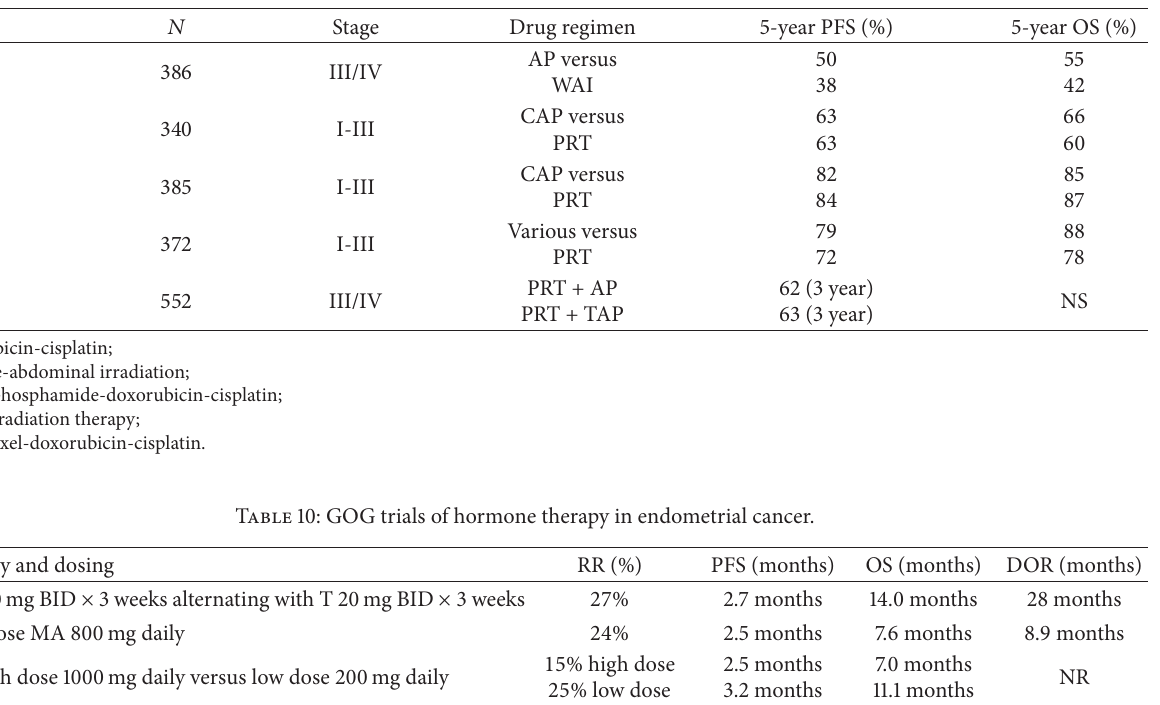
Table 9: Adjuvant treatment in endometrial cancer trials: radiation versus chemotherapy versus combination.